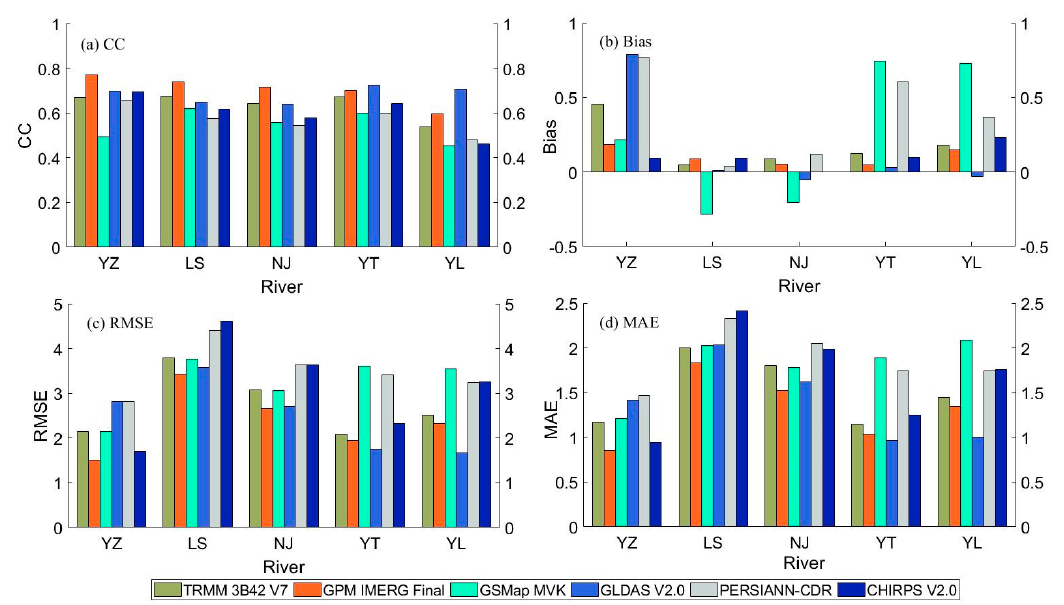
Figure 3. Quantitative analysis results of six satellite precipitation products in five river basins, ( a ) a represents the CC value of six products on each basin; ( b ) a represents the Bias value of six products on each basin; ( c ) a represents the RMSE value of six products on each basin; ( d ) a represents the MAE value of six products on each basin.